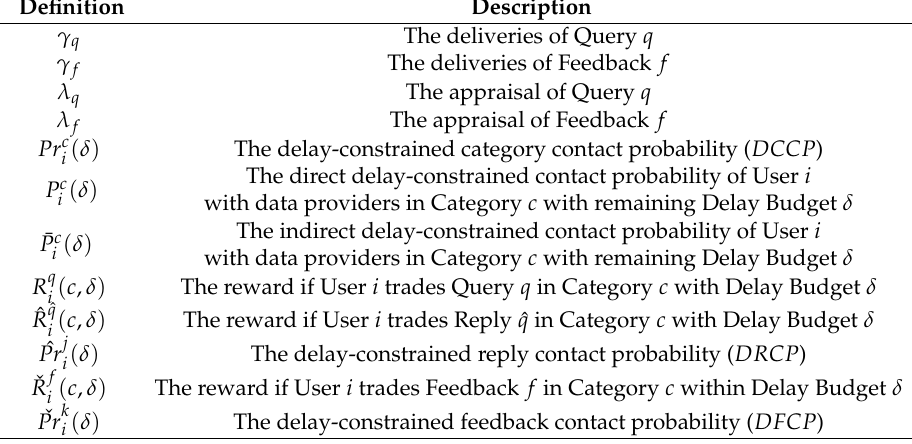
Table 1. The main definitions in the